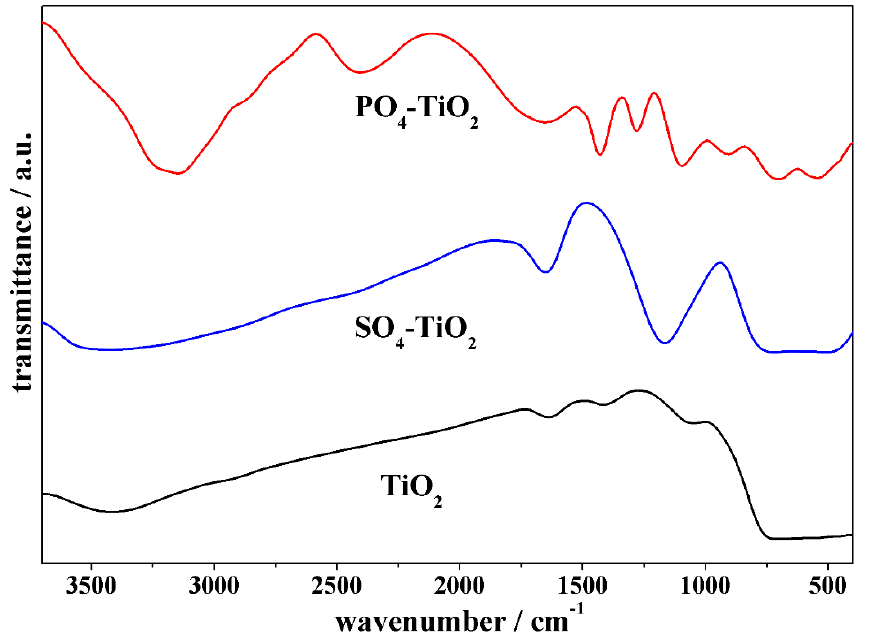
Figure 2. FTIR spectra of TiO 2 , PO 4 -TiO 2, and SO 4 -TiO 2 .